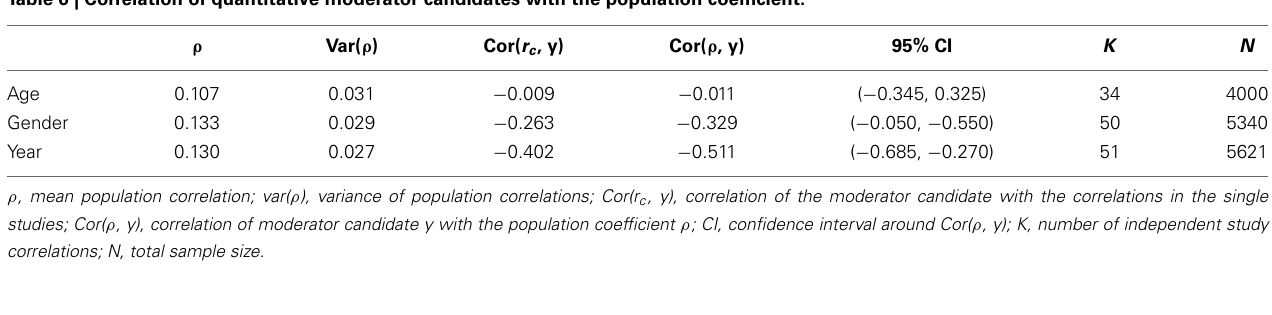
Table 6 | Correlation of quantitative moderator candidates with the population